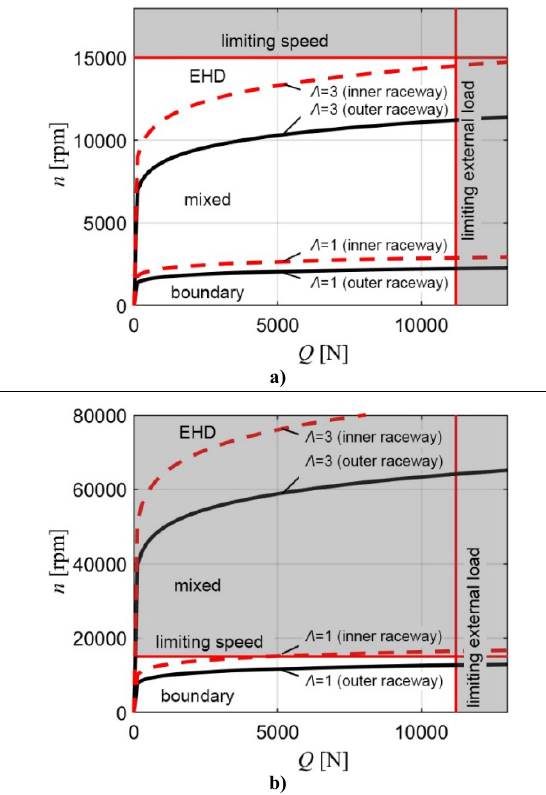
Figure 5. A plot that shows a lubrication regime dependence on the number of revolutions n and external radial load Q for rolling bearing 6206 and lubricant Advanced Ester, with contact surfaces roughness of R ar =0.14 μ m and R ab =0.05 μ m and operating temperature of a) 38°C, b)